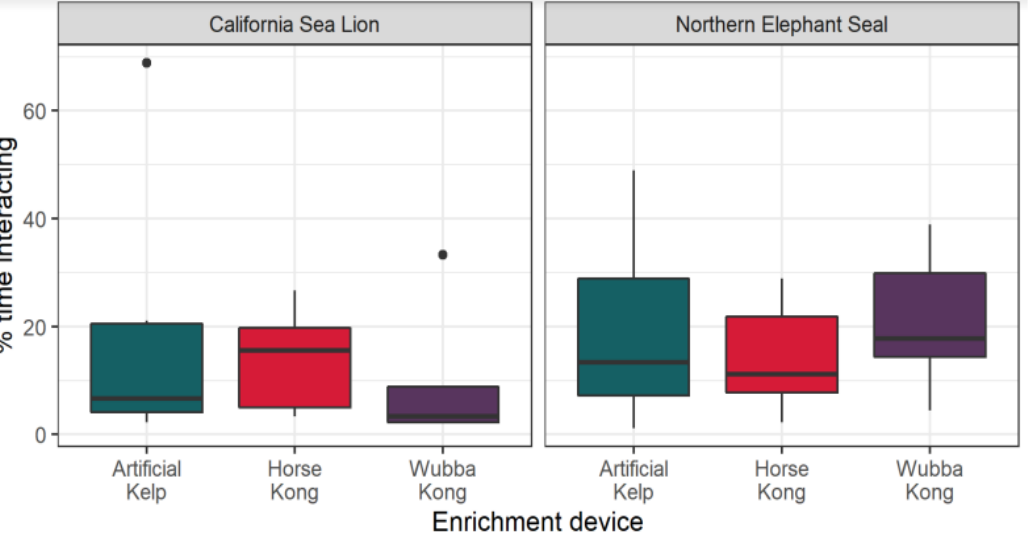
Figure 3. Proportional numbers of interactions (% time interacting) with EEDs per species during a 30-min presentation session, recorded by in-person focal instantaneous sampling. Bars describe medians, first quartile, third quartile (bars) and maxima and minima (whiskers). Black dots high- light outliers.